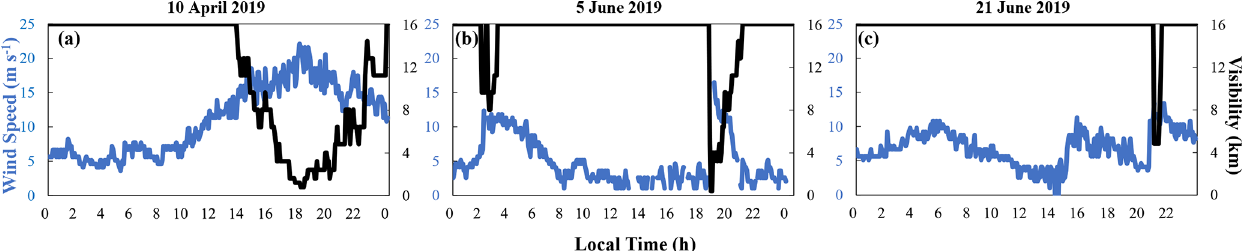
Figure 2. Changes in meteorological conditions: wind speed (blue) and visibility (black) as measured on each of the dust event days.